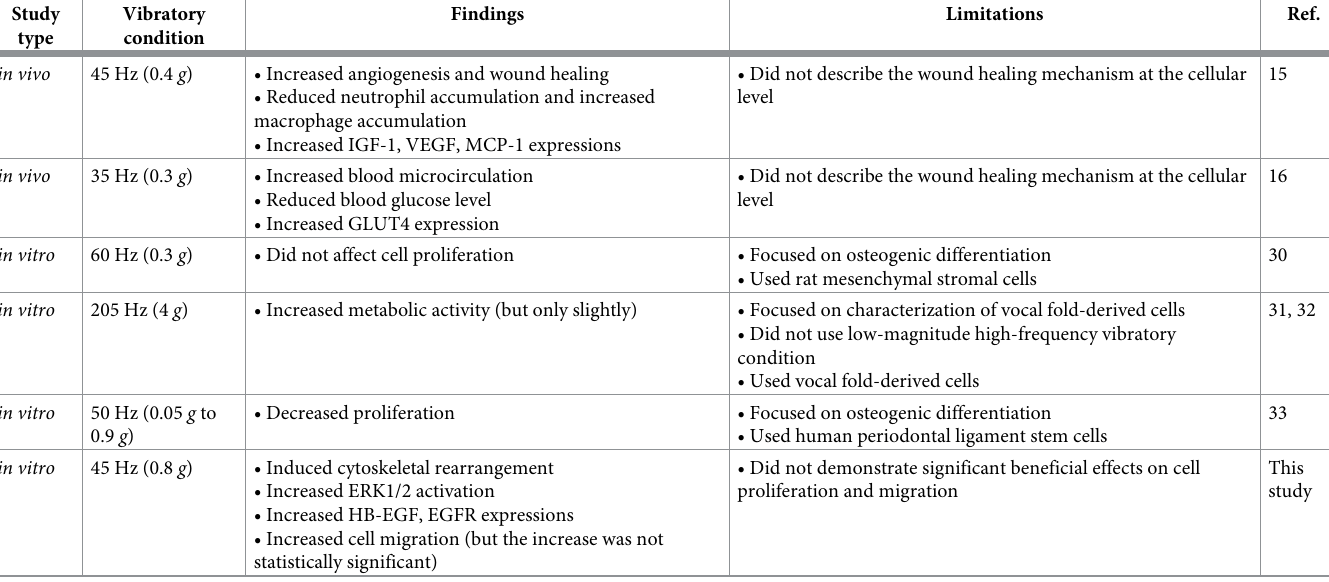
Table 2. Comparison of the findings and limitations of studies related to the wound healing effects of